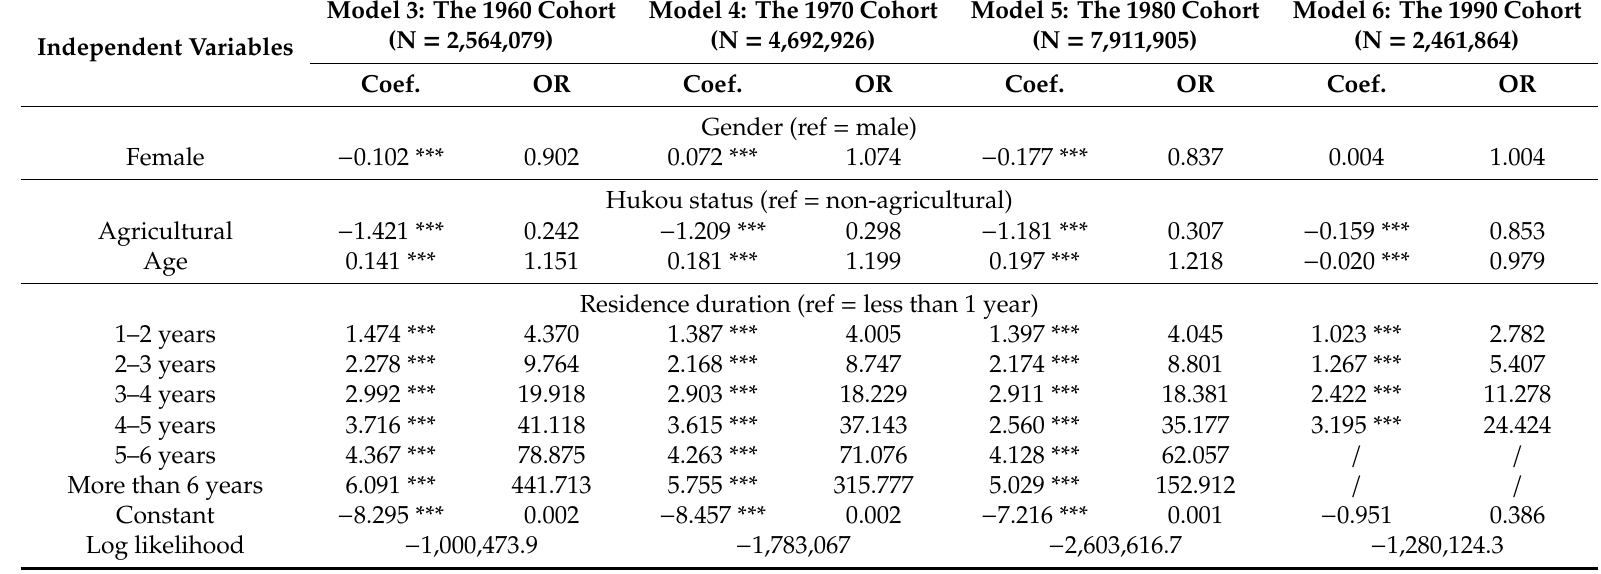
Table 5. Regression results on individual characteristics and actual urban residence by